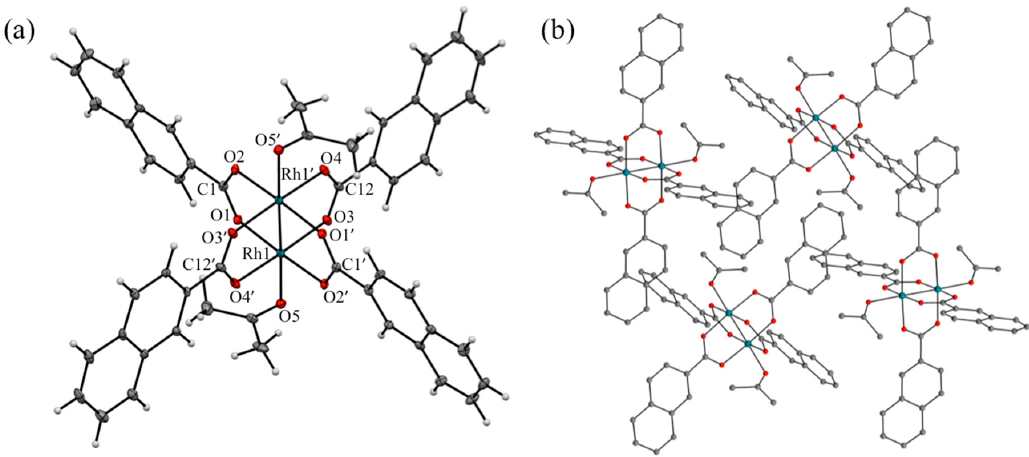
Figure 3. ( a ) ORTEP diagram (thermal ellipsoid: 30%); and ( b ) expanded surrounding structure of [2(OCMe 2 ) 2 ] crystal. In ( b ), hydrogen atoms are omitted for clarity.